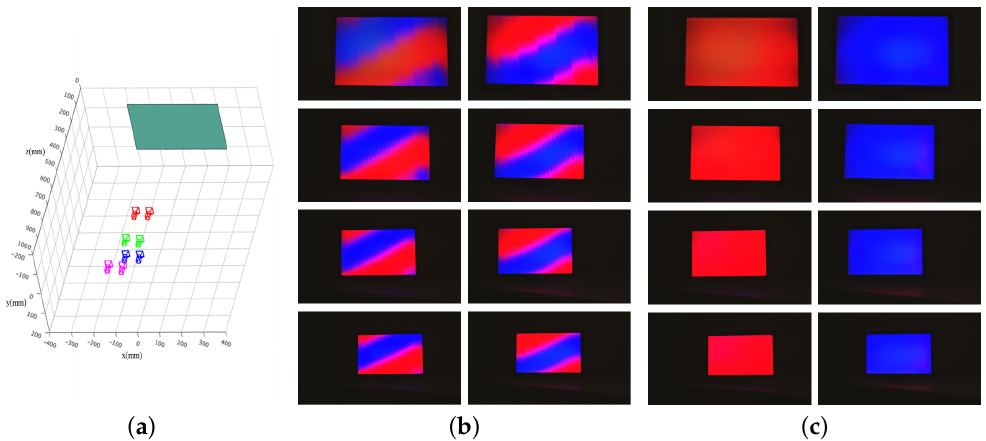
Figure 11. Examples of the two-view image captured at different distances: ( a ) captured positions of the stereo camera with a fake facial image; ( b ) captured images of no-calibration; and ( c ) captured images using the proposed method. The images in Rows 1–4 were captured in the positions at the test positions #1–#4, which are colored in red, green, blue, and magenta in ( a ), respectively. Table 3. Crosstalk evaluation of the ETAD using red-blue